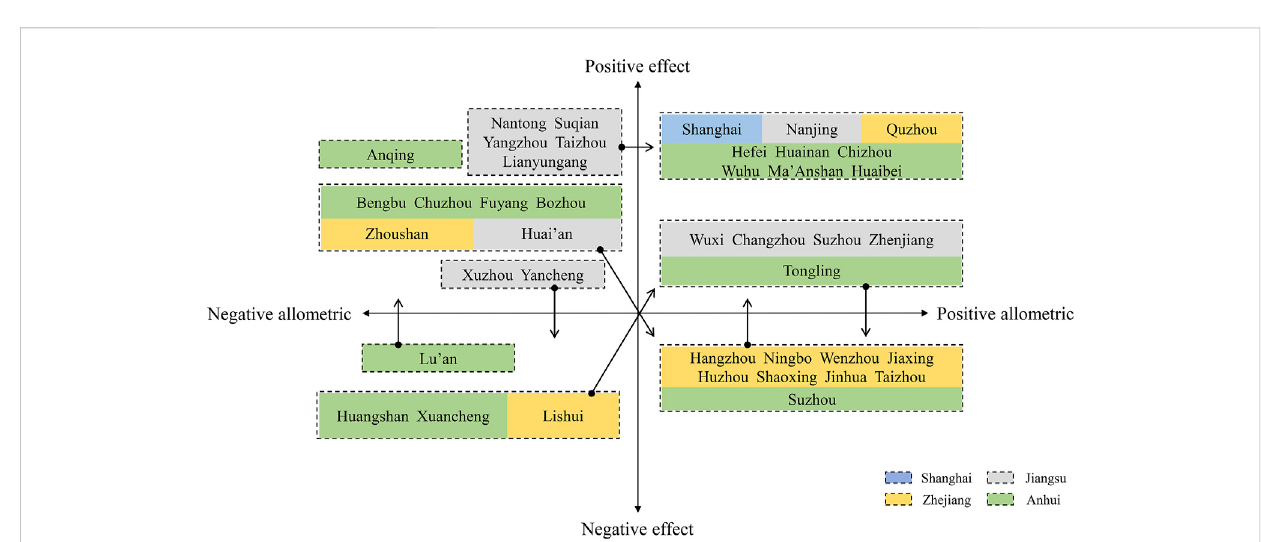
FIGURE 5 Evolution of economic agglomeration effect of allometric growth from 2000 to